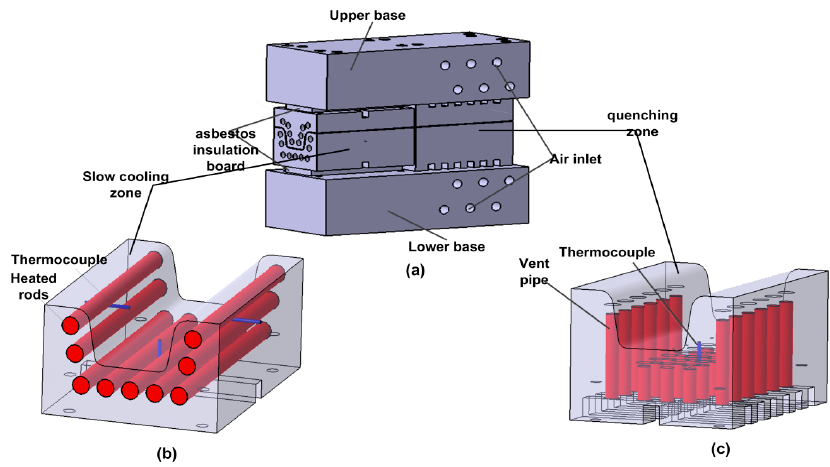
Figure 2. Schematic of the die: ( a ) overall structure, ( b ) slow cooling zone, and ( c ) quenching zone.